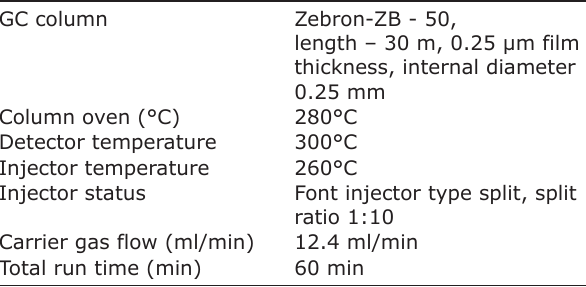
Table-1: GC operating